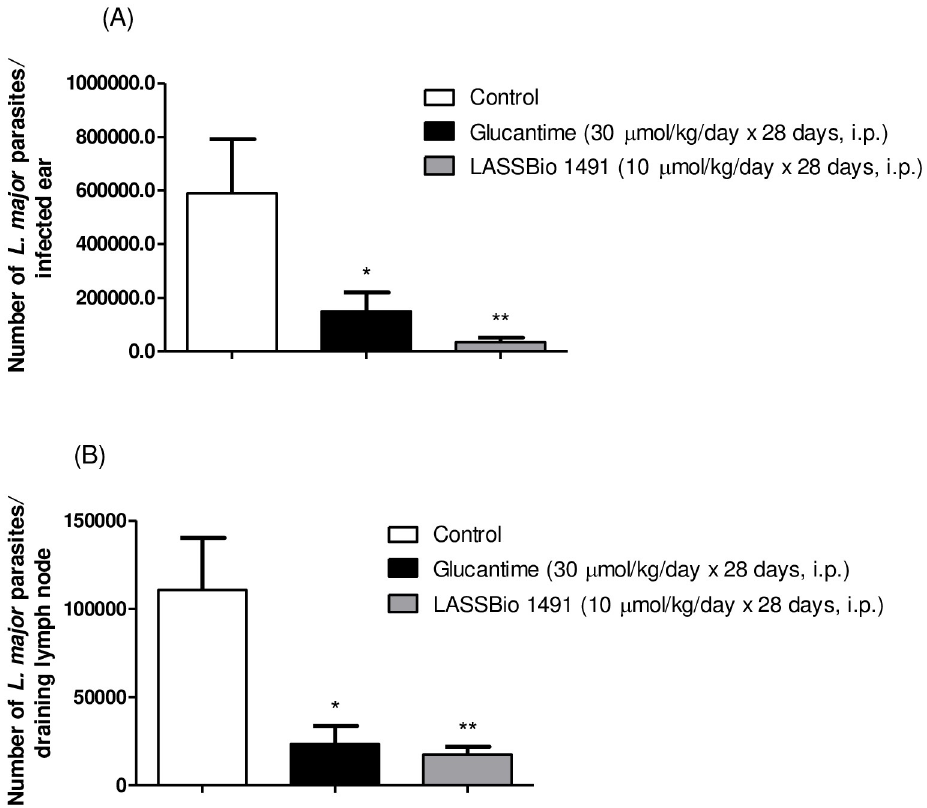
Fig 4. Parasite burden throughout the course of treatments with LASSBio-1491 (10 μ mols/kg/day x 28 days, i.p.) and glucantime (30 μ mols/kg/day x 28 days, i.p.) in BALB/c mice infected with L . major LV39. (A) Number of L . major parasites in the infected ears. (B) Number of L . major parasites in the draining lymph node. The parasite loads of infected ears and draining lymph nodes were determined using a quantitative limiting-dilution assay. The values represent the mean parasites loads of five mice in each group, and the bars represent the standard error of the mean. � P < 0.05, �� P < 0.01 vs. control.